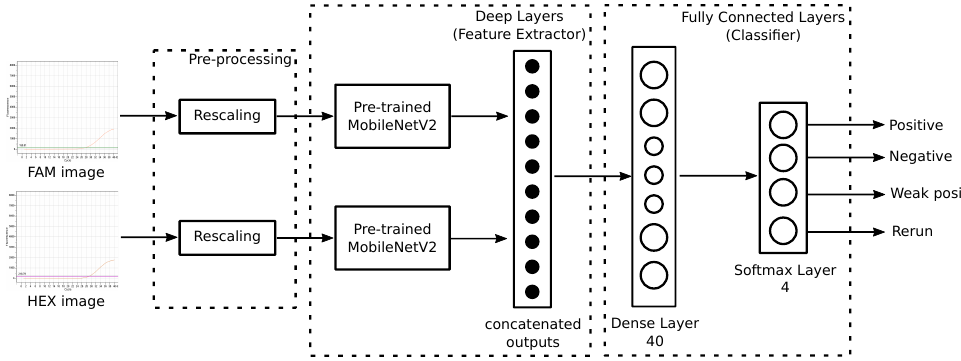
Figure 2. The multi-input image DCNN model where the two MobileNetV2 models are used simultaneously to extract deep features from FAM and HEX images.